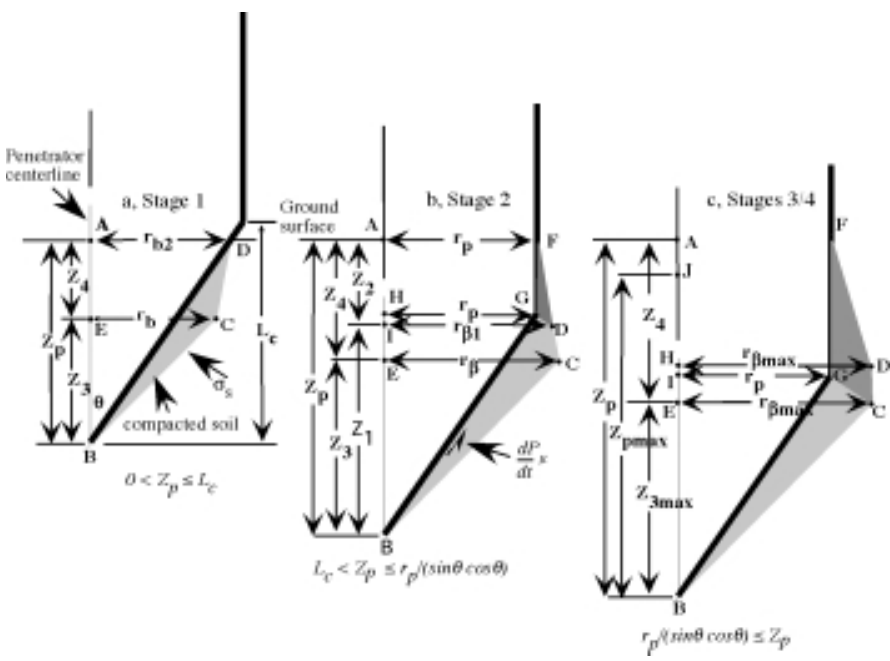
Fig. 2. The four stages of penetration. Stages 3 & 4 are shown together in (c) since the only difference between them is that the penetrator aftbody is not completely beneath the soil surface in stage 3, but is completely buried in stage